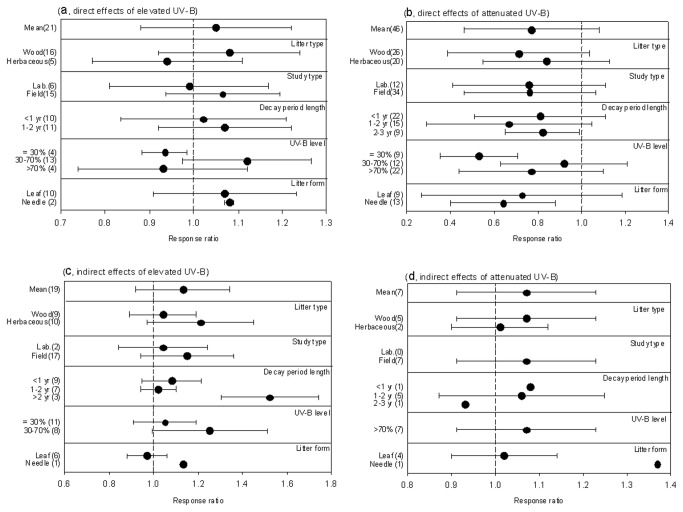
Untransformed response ratios pertaining to UV-B effects on litter decomposition.Direct effects of elevated UV-B (a) and attenuated UV-B (b) as well as indirect effects of elevated UV-B (c) and attenuated UV-B (d) on litter decomposition. Dots with error bars denote the overall mean response ratio with a 95% CI. Wood denotes litter from woody plants; herbaceous denotes litter from herbaceous plants. Lab. denotes the study was carried out in a laboratory; field denotes the study was carried out in the field.